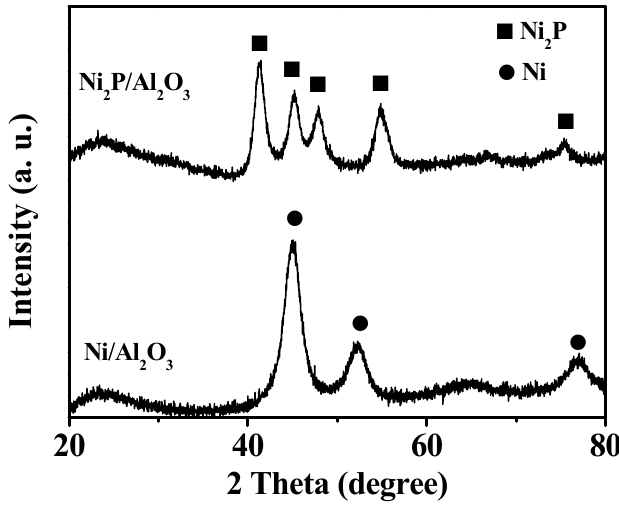
2 O 3 and Ni 2 P/Al 2 O 3 catalyst.